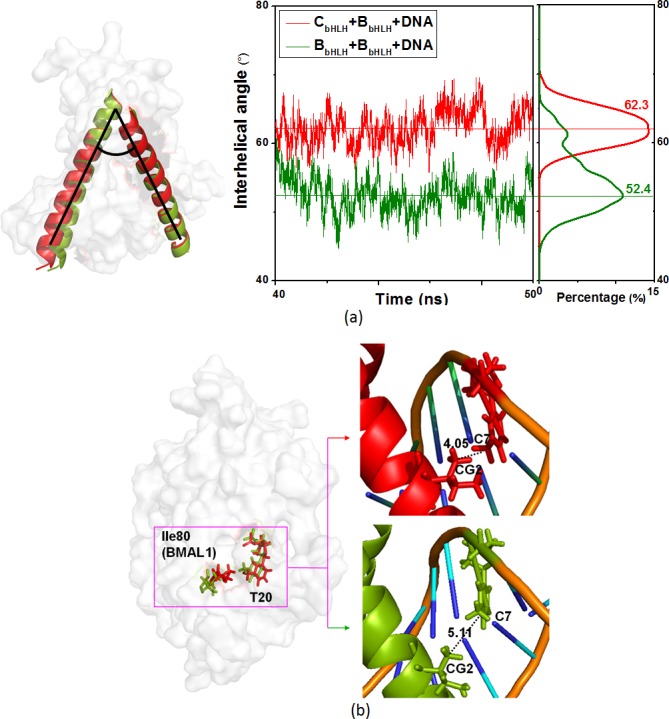
The interhelical angles and the distances of the CbHLH+BbHLH+DNA and BbHLH+BbHLH+DNA models.(a) The interhelical angles (°) between the H1 helices, and (b) the distances (Å) between the C atoms for Ile80 in the H1 helix of BMAL1 and T20 in DNA in the CbHLH+BbHLH+DNA (red) and BbHLH+BbHLH+DNA (green) models.